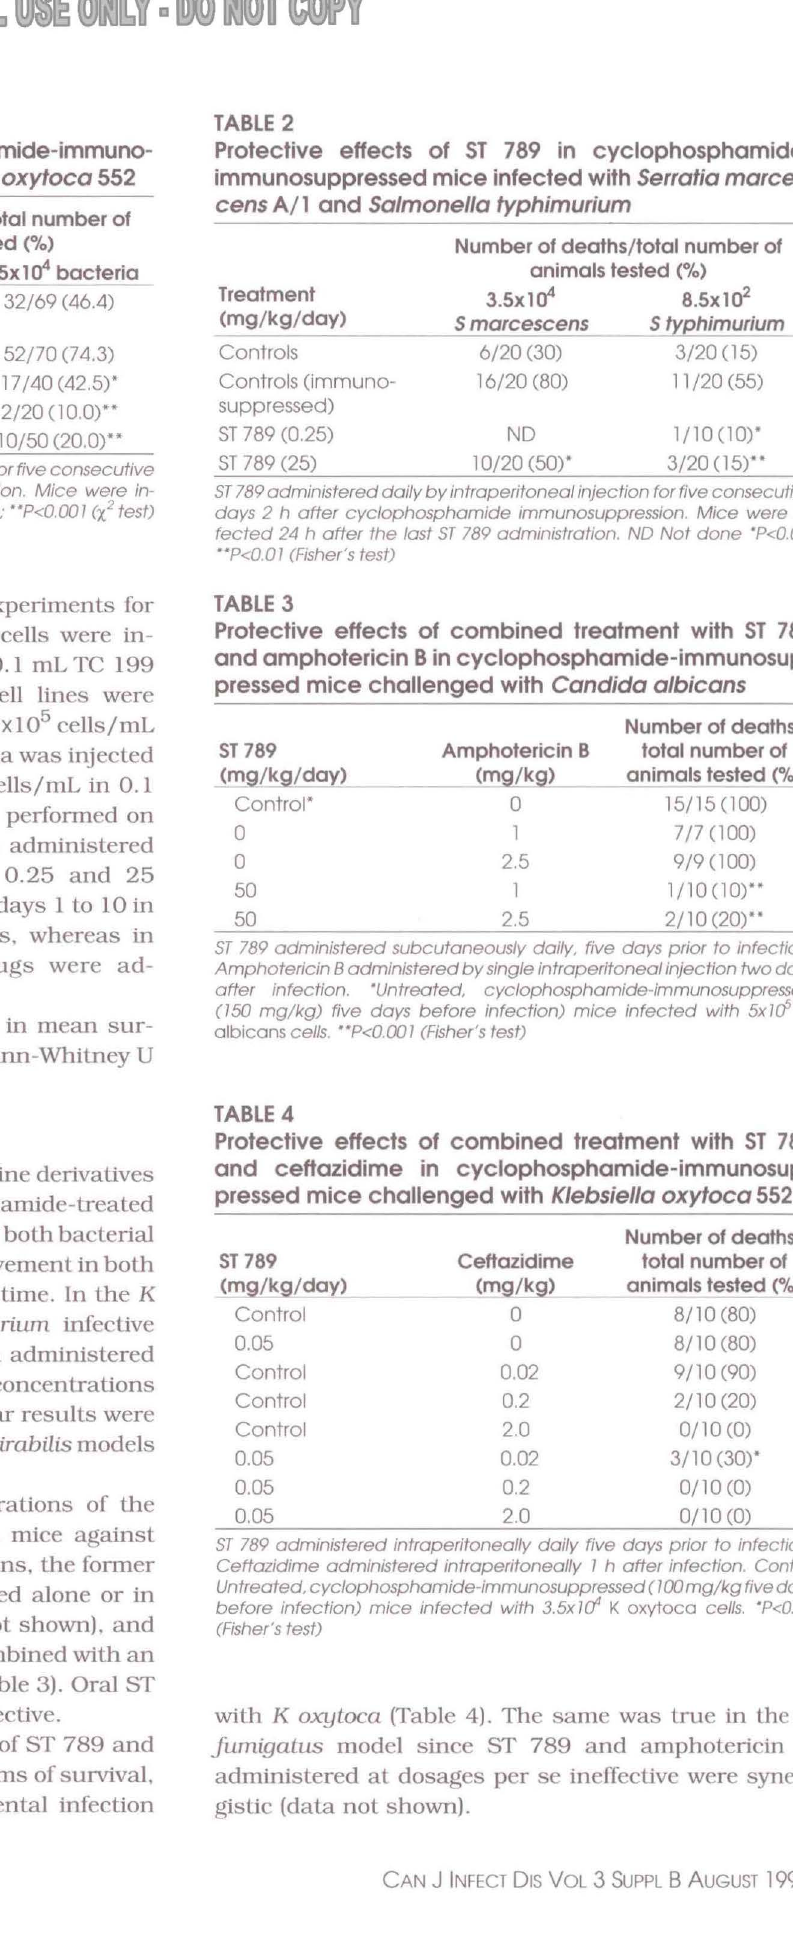
Protective effects of ST 789 in cyclophosphamide immunosuppressed mice infected with Serratia marces cens AI 1 and Salmonella typhimurium